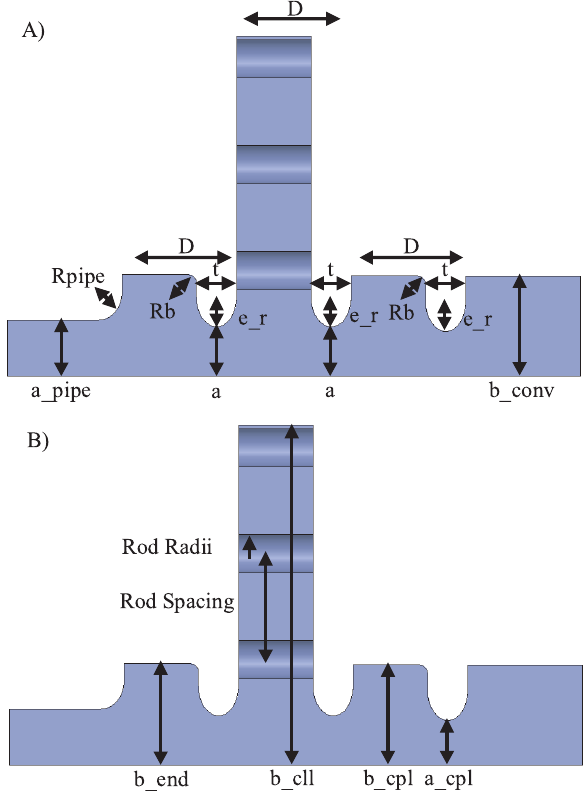
FIG. 5. Geometric parameters of PBG structure: (A) fixed parameters, (B) free tuning parameters, as shown in Tables I and II, respectively.